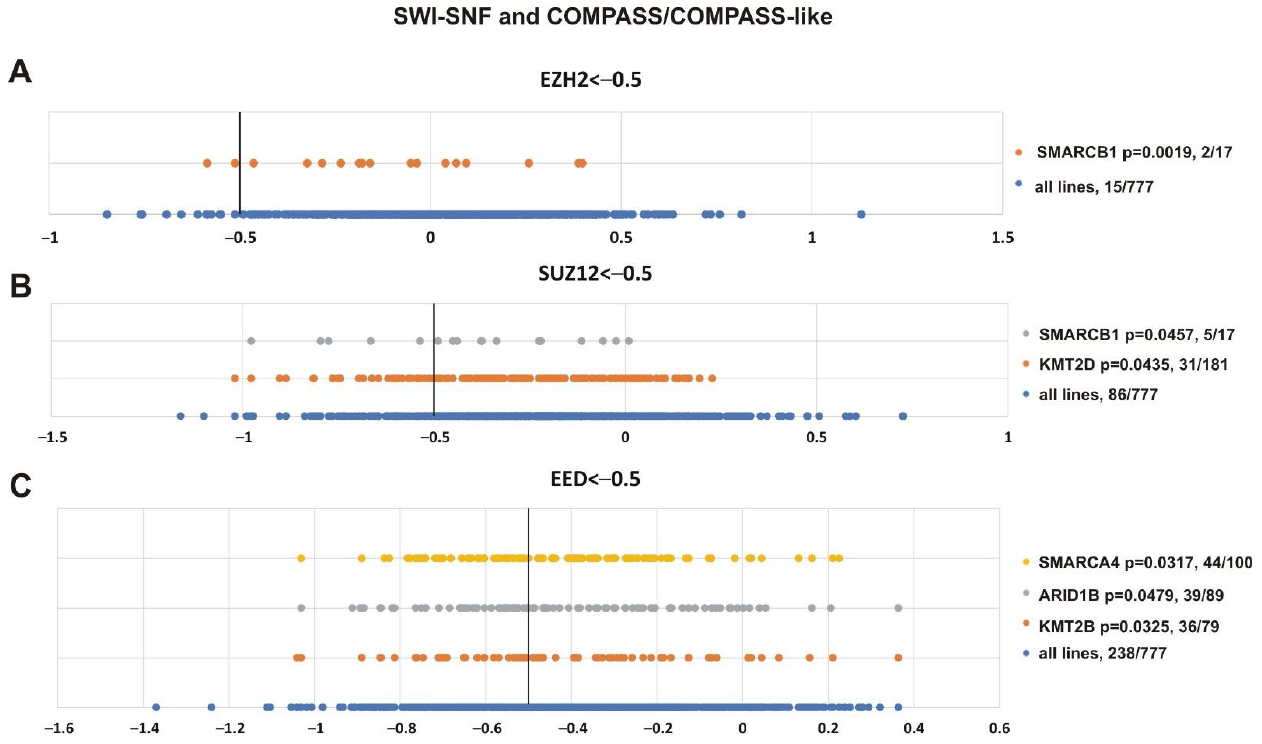
Figure 8. Mutations in genes encoding subunits of the SWI/SNF and COMPASS-like complexes correlate with sensitivity to PRC2 knockout. ( A ) EZH2 , ( B ) SUZ12 and ( C ) EED. The X-axis shows the dependency scores of the lines with alterations of a particular gene (orange, grey and yellow circles) vs. all cell lines (blue circles, 777 in total). Black bold vertical line indicates the dependency score −0.5 (the score <−0.5 mean that gene is critical for cells survival). p -value — the statistical significancy for hypothesis that the cell lines with SWI/SNF or COMPASS mutations will have a score of less than −0.5. The number of cancer cell lines bearing an altered gene with a score <−0.5/total number of cell lines bearing the altered gene is indicated at the right.